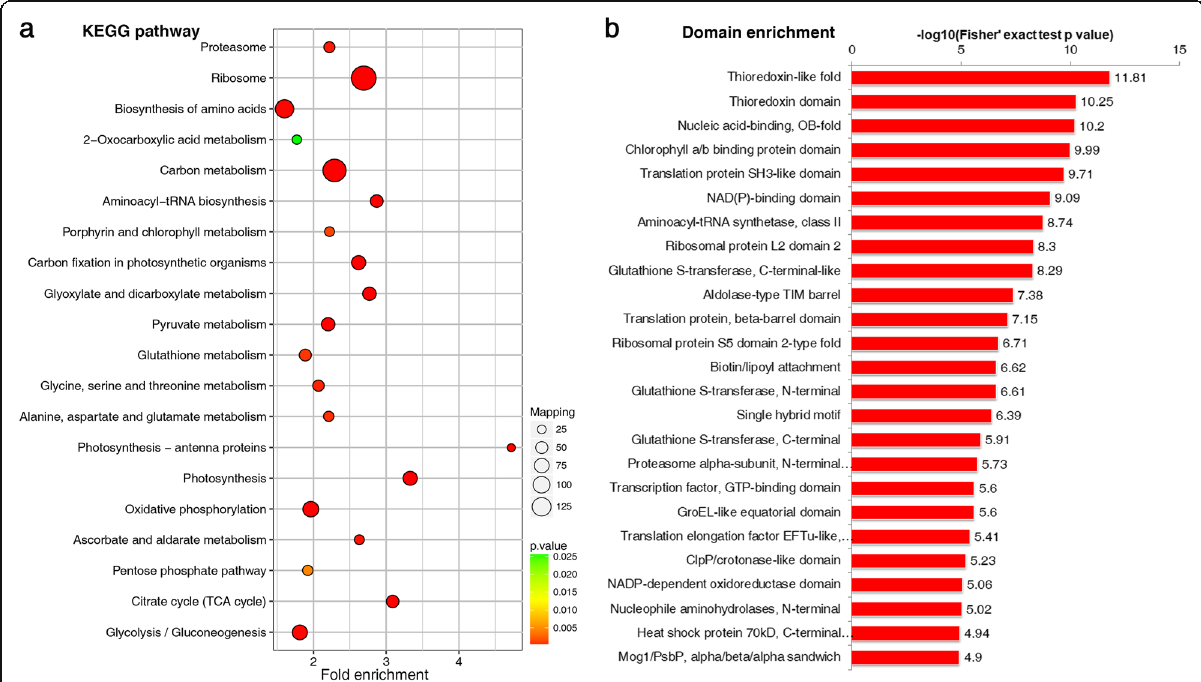
Fig. 4 KEGG pathway and Protein domain enrichment analyses of 2-hydroxyisobutyrylated